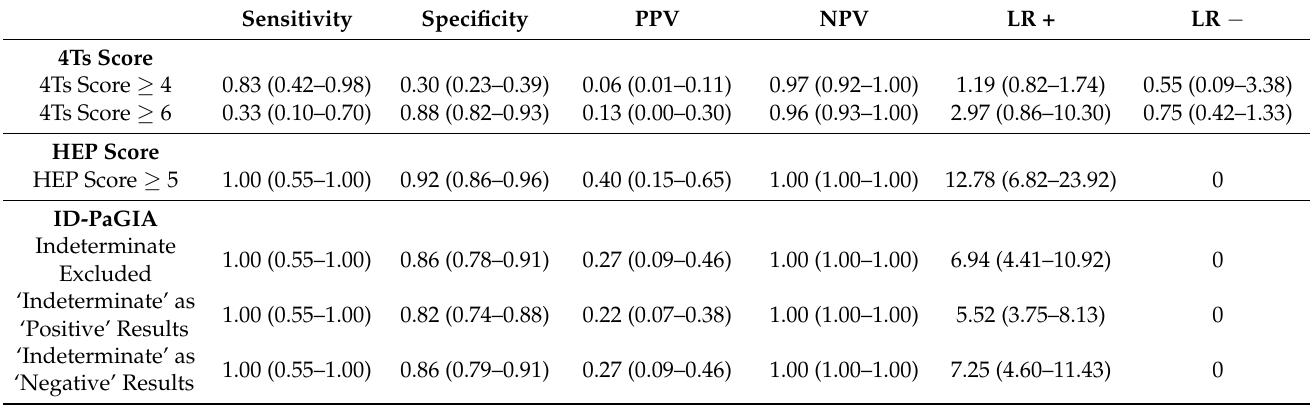
Table 3. Diagnostic accuracy of clinical and biological tests in heparin-induced